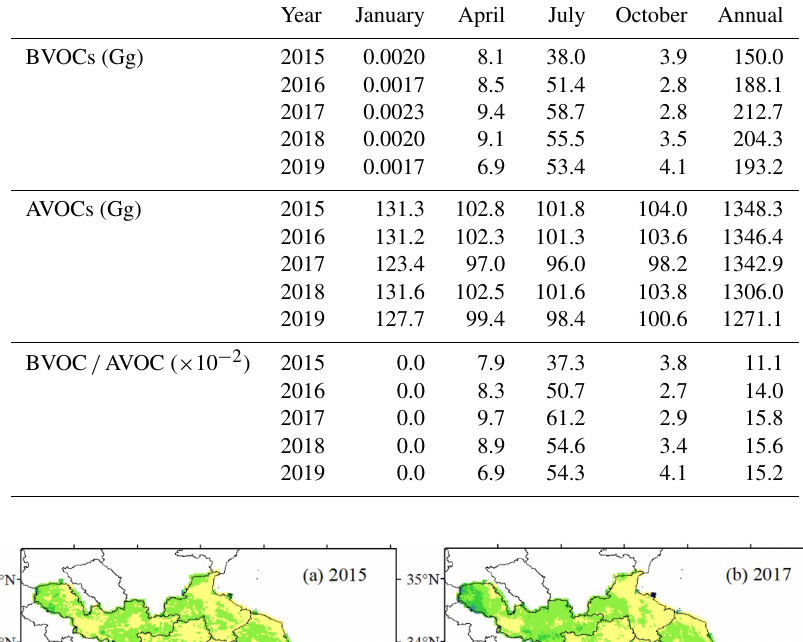
Table 1. Annual emissions of BVOCs and AVOCs and the ratios of BVOCs to AVOCs.